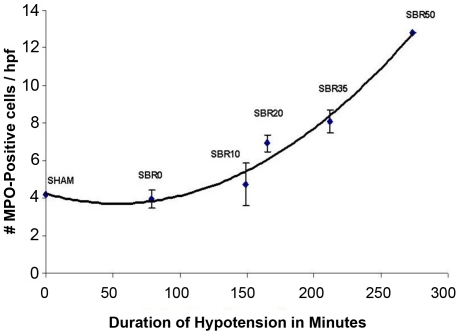
Effect of shock severity on liver inflammation.Rats were subjected to sham protocol (S) or to T/HS protocol with increasing duration of shock as indicated followed by resuscitation. The livers were harvested 60 minutes after the start of resuscitation. Sections of paraformaldehyde-fixed liver were stained to detect myeloperoxidase (MPO) activity and the number of MPO-positive cells counted. Data shown represents the number of MPO-positive cells/high power field in 20 random 1,000x fields. Curve fitting was performed and the best-fitting curve shown; the number of MPO-positive cells increased exponentially with duration of hypotension (Pearson correlation coefficient = 0.869, p<0.0001).